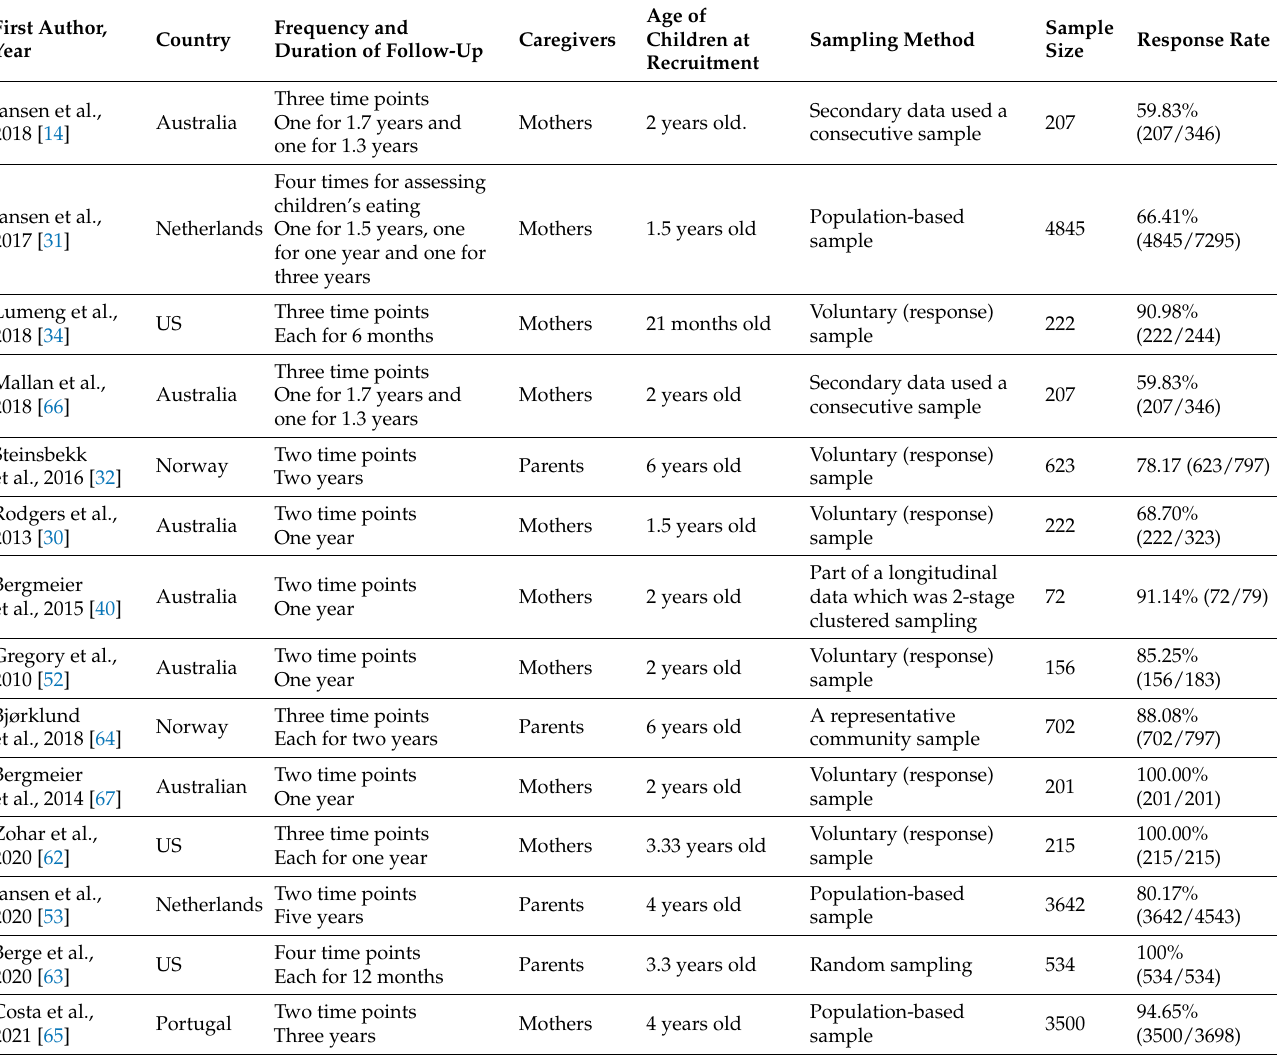
Table 1. Characteristics of the studies ( n =